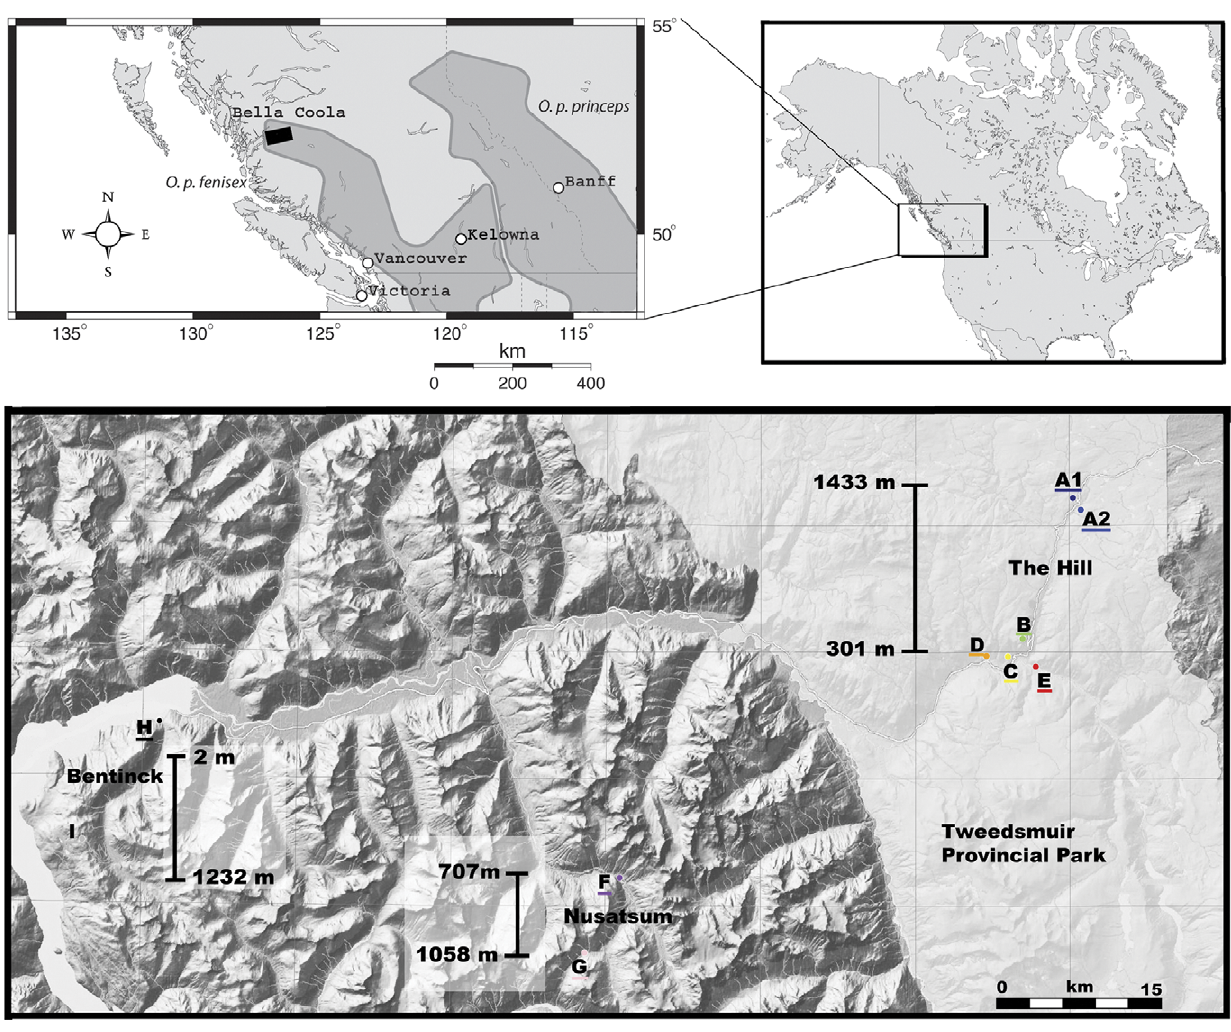
Figure 1. Map of the study area in the Bella Coola Valley, British Columbia, Canada, with the ten sampling sites located along three altitudinal gradients (lowest and highest elevations indicated): the Hill, Nusatsum and Bentinck from east to west. The light shading indicates Tweedsmuir South Provincial Park. The inset on the top left indicates the distribution of O. princeps subspecies.